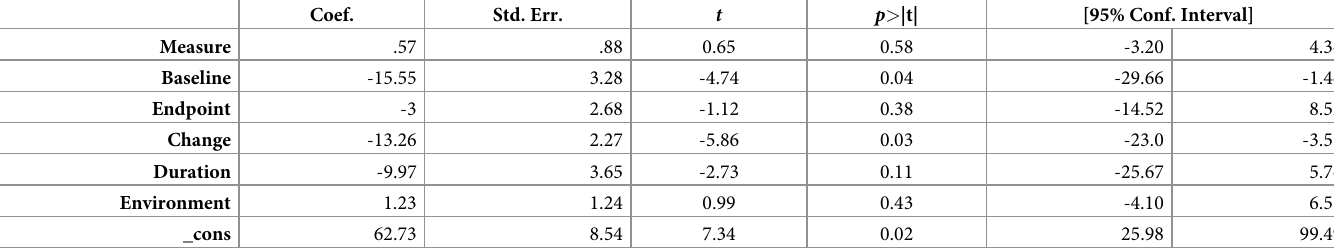
Table 2. Regression analysis of heterogeneity factors for upper limb muscle strength.